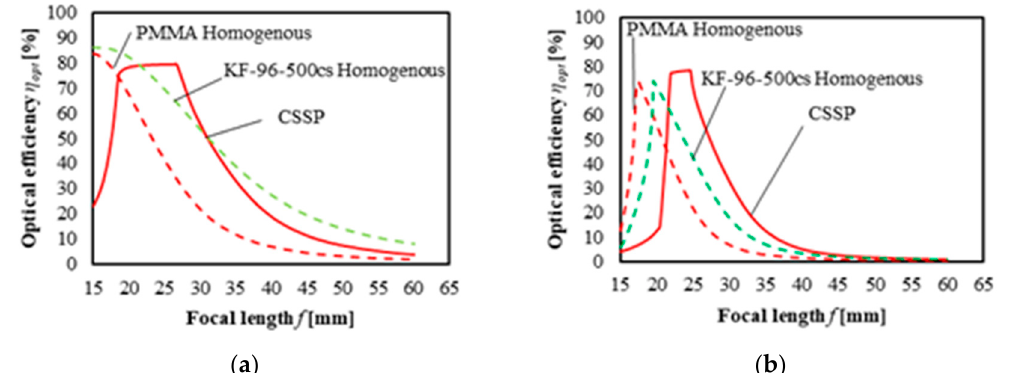
Figure 8. Simulated optical efficiency across varied focal lengths for the homogenous and core-shell spherical lenses with a the geometric concentration ratio C of ( a ) 6.25 × and ( b ) 100 × .